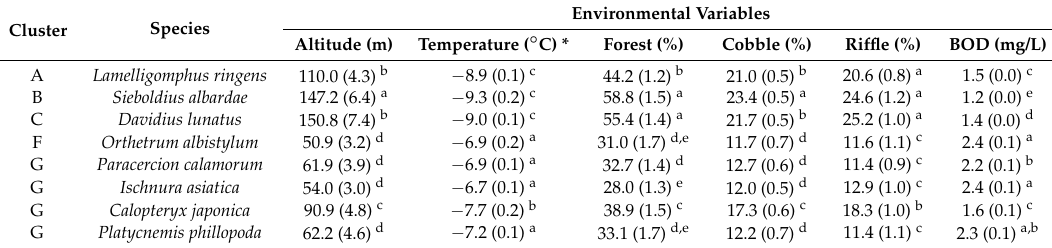
Figure 7. Differences in environmental variables in the seven different clusters. Different letters represent significant differences among clusters based on Dunn’s multiple comparisons tests ( p < 0.05). Error bar represents the standard error in each cluster. Table 3. Differences (mean ± SE) of environmental variables among selected indicator species in each cluster. Different letters present significant differences between species based on Dunn’s multiple comparison test ( p < 0.05). We selected eight dominant indicator species which showed occurrence frequency which were observed at more than 200 sampling sites, as shown Figure 2c.